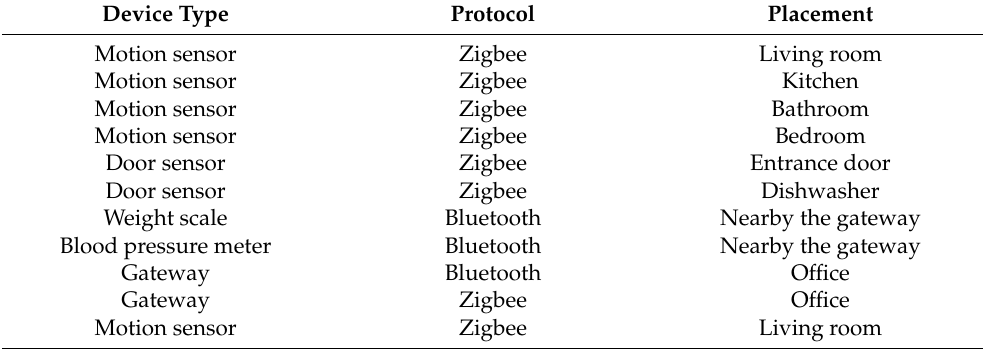
Table 3. Device deployment locations [38].